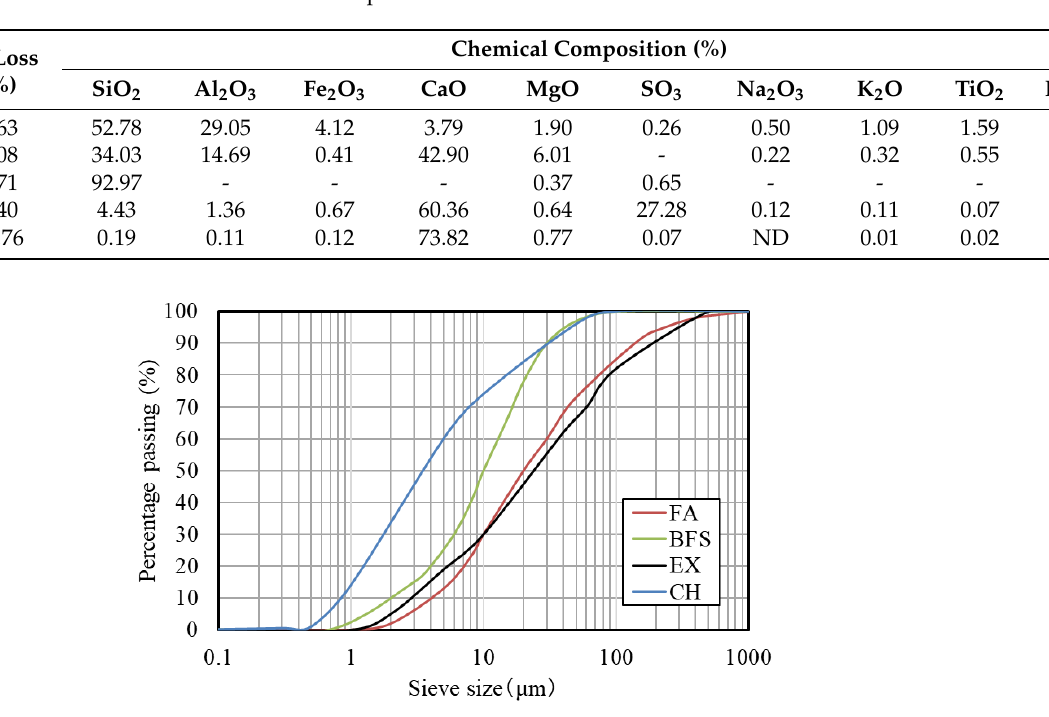
Table 2. Chemical Compositions of Materials.